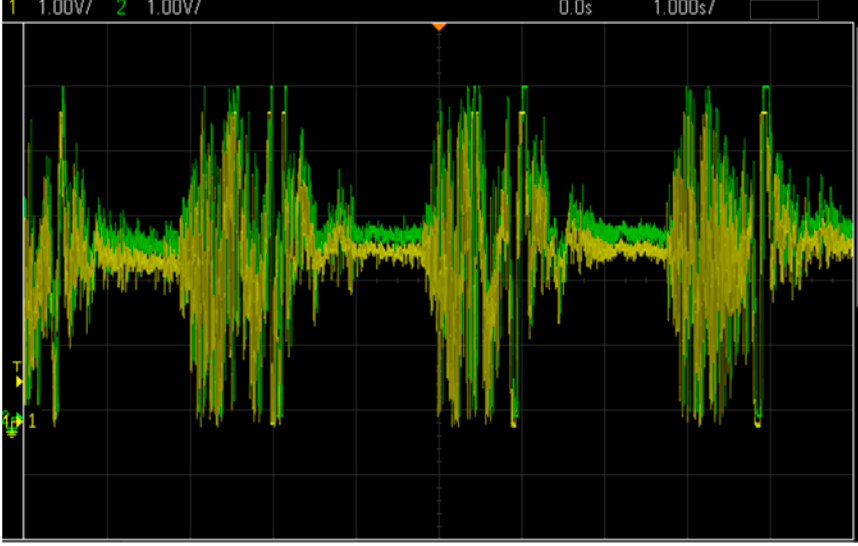
Figure 24. EMG with Raspberry